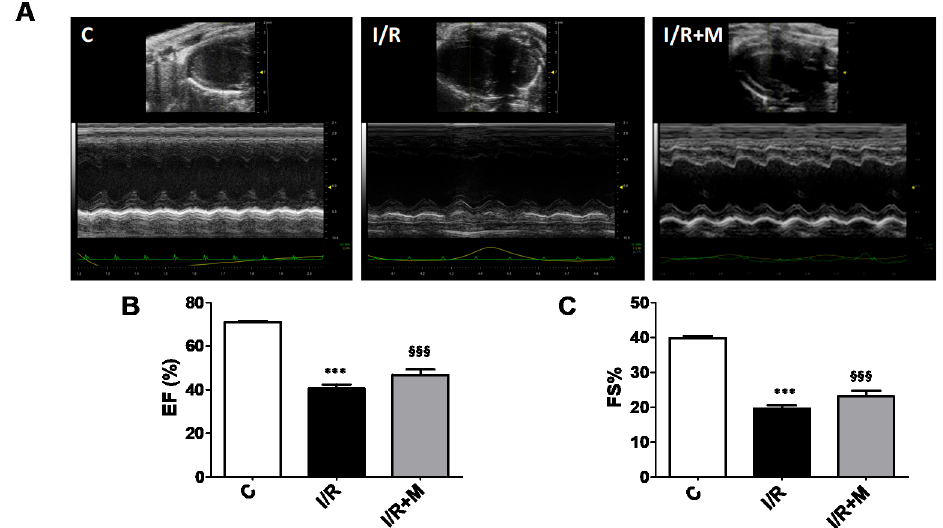
Figure 6. Echocardiographic functional parameters of mice after 14 days of cardiac I/R. ( A ) Representative 2D-M-Mode echocardiographic images of vehicle- or metformin-treated mice subjected to 14 days of I/R. ( B ) Ejection fraction (EF) and ( C ) fractional shortening (FS) invehicle- or metformin-treated I/R mice ( n = 3 per group). Data are presented as mean ± SEM. One-way ANOVA followed by Bonferroni’s post hoc test: *** p < 0.001, §§§ p < 0.001 vs. control (C) .